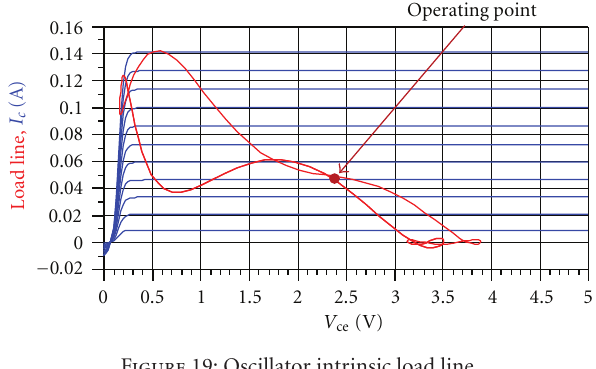
Figure 19: Oscillator intrinsic load line. Table 5: Comparison of oscillator